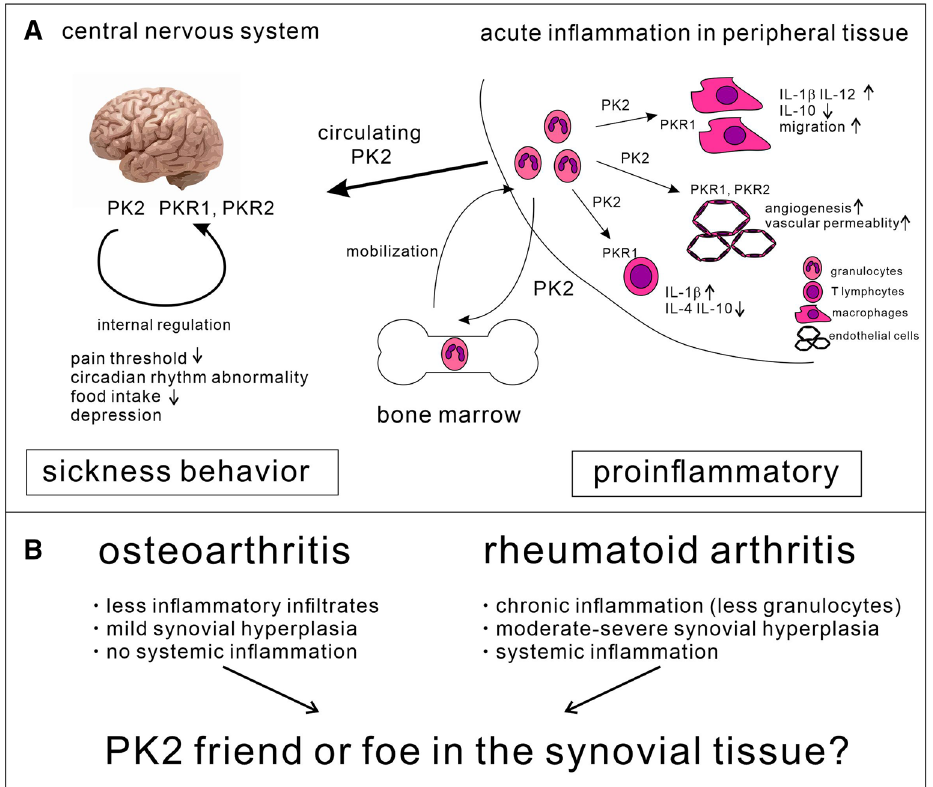
Figure 1. PK2 as a regulator of inflammation and sickness behaviors. ( A ) In acute inflammatory tissue, PK2 is secreted by infiltrating granulocytes. Secreted PK2 mobilizes granulocytes from the bone